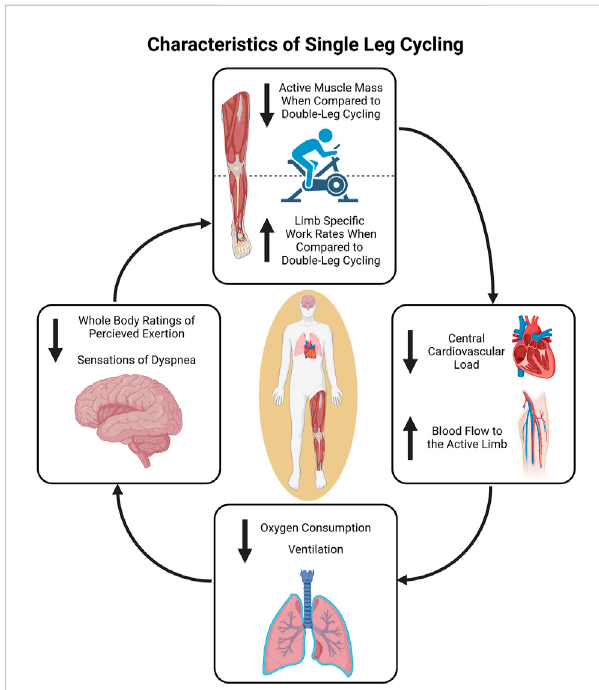
FIGURE 1 Overview of the physiological characteristics of single-leg cycling. The reduction in active muscle mass compared to double-leg cycling results in decreased central demands. This can in turn be utilized to facilitate comparatively greater limb speci fi c work rates during single-leg cycling if central output is matched. Figure created in BioRender.com, with